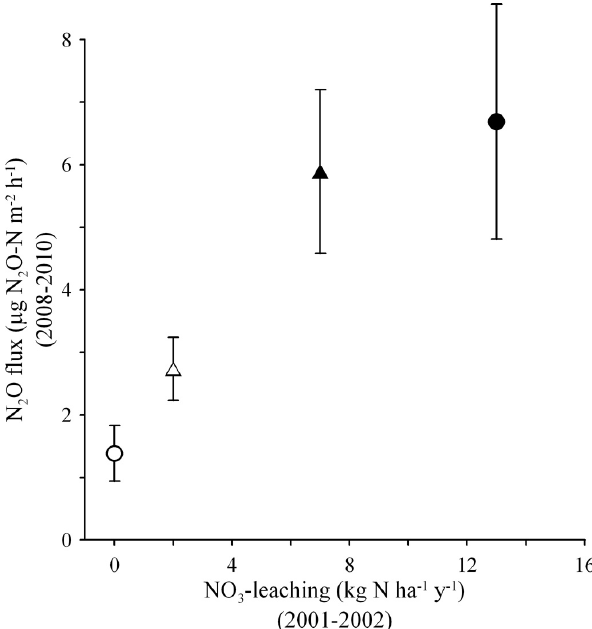
Fig. 5. Relationship between stand average N 2 O flux and estimated NO − leaching from Hansen et al. (2007). Norway spruce 1969 ( • ), 3 Norway spruce 1997 ( ◦ ), Oak 1970 ( N ), Oak 1993 ( 1)